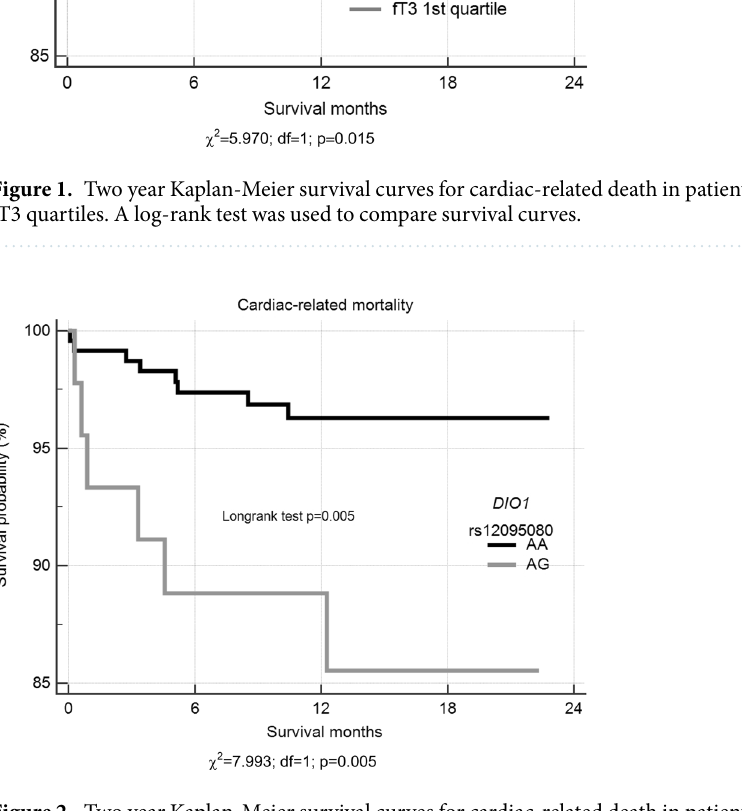
Figure 2. Two year Kaplan-Meier survival curves for cardiac-related death in patients with AMI according to D1O1 rs12095080 genotypes. A log-rank test was used to compare survival